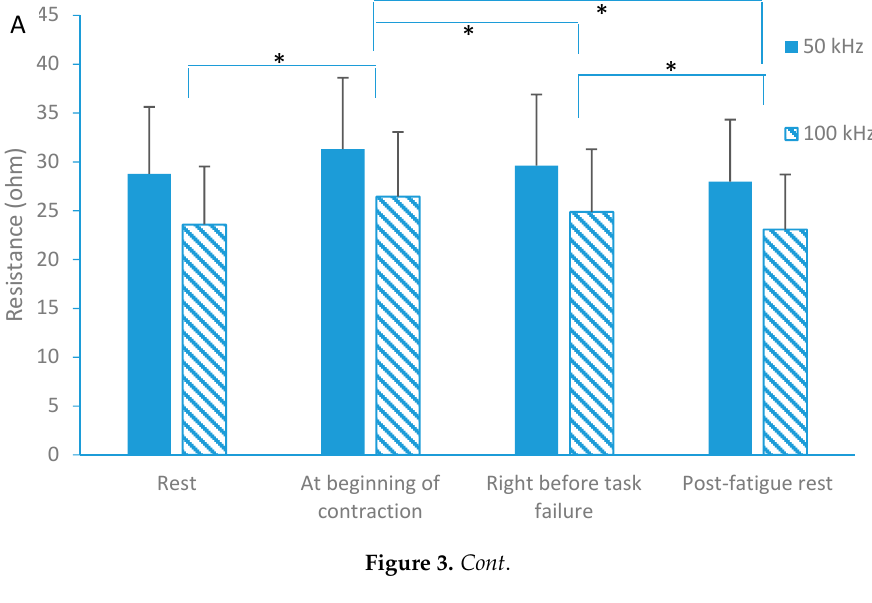
Figure 2. Resistance ( A ) and Reactance ( B ) at isometric contraction with two different frequencies (50 kHz and 100 kHz) (mean ± standard deviation, * indicates p < 0.05 between contraction levels).